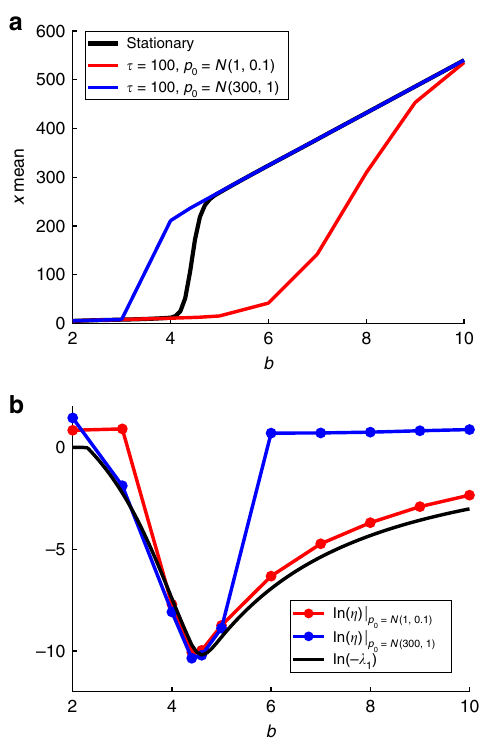
Fig. 2 Parameter region leading to bimodal distributions. a Mean x -values plotted as a function of parameter b for different initial conditions. Simulations have been carried out in SELANSI 18 . b Convergence rates of the solution ( η from (8) and λ 1 from matrix M expressed in units of inverse of time) toward the equilibrium distribution in logarithmic scale. Such slow dynamics is responsible for the phenomenon of transient hysteresis. If the system is allowed to achieve the equilibrium, hysteresis disappears. The parameter region leading to bimodal distributions corresponds with the slowest convergence